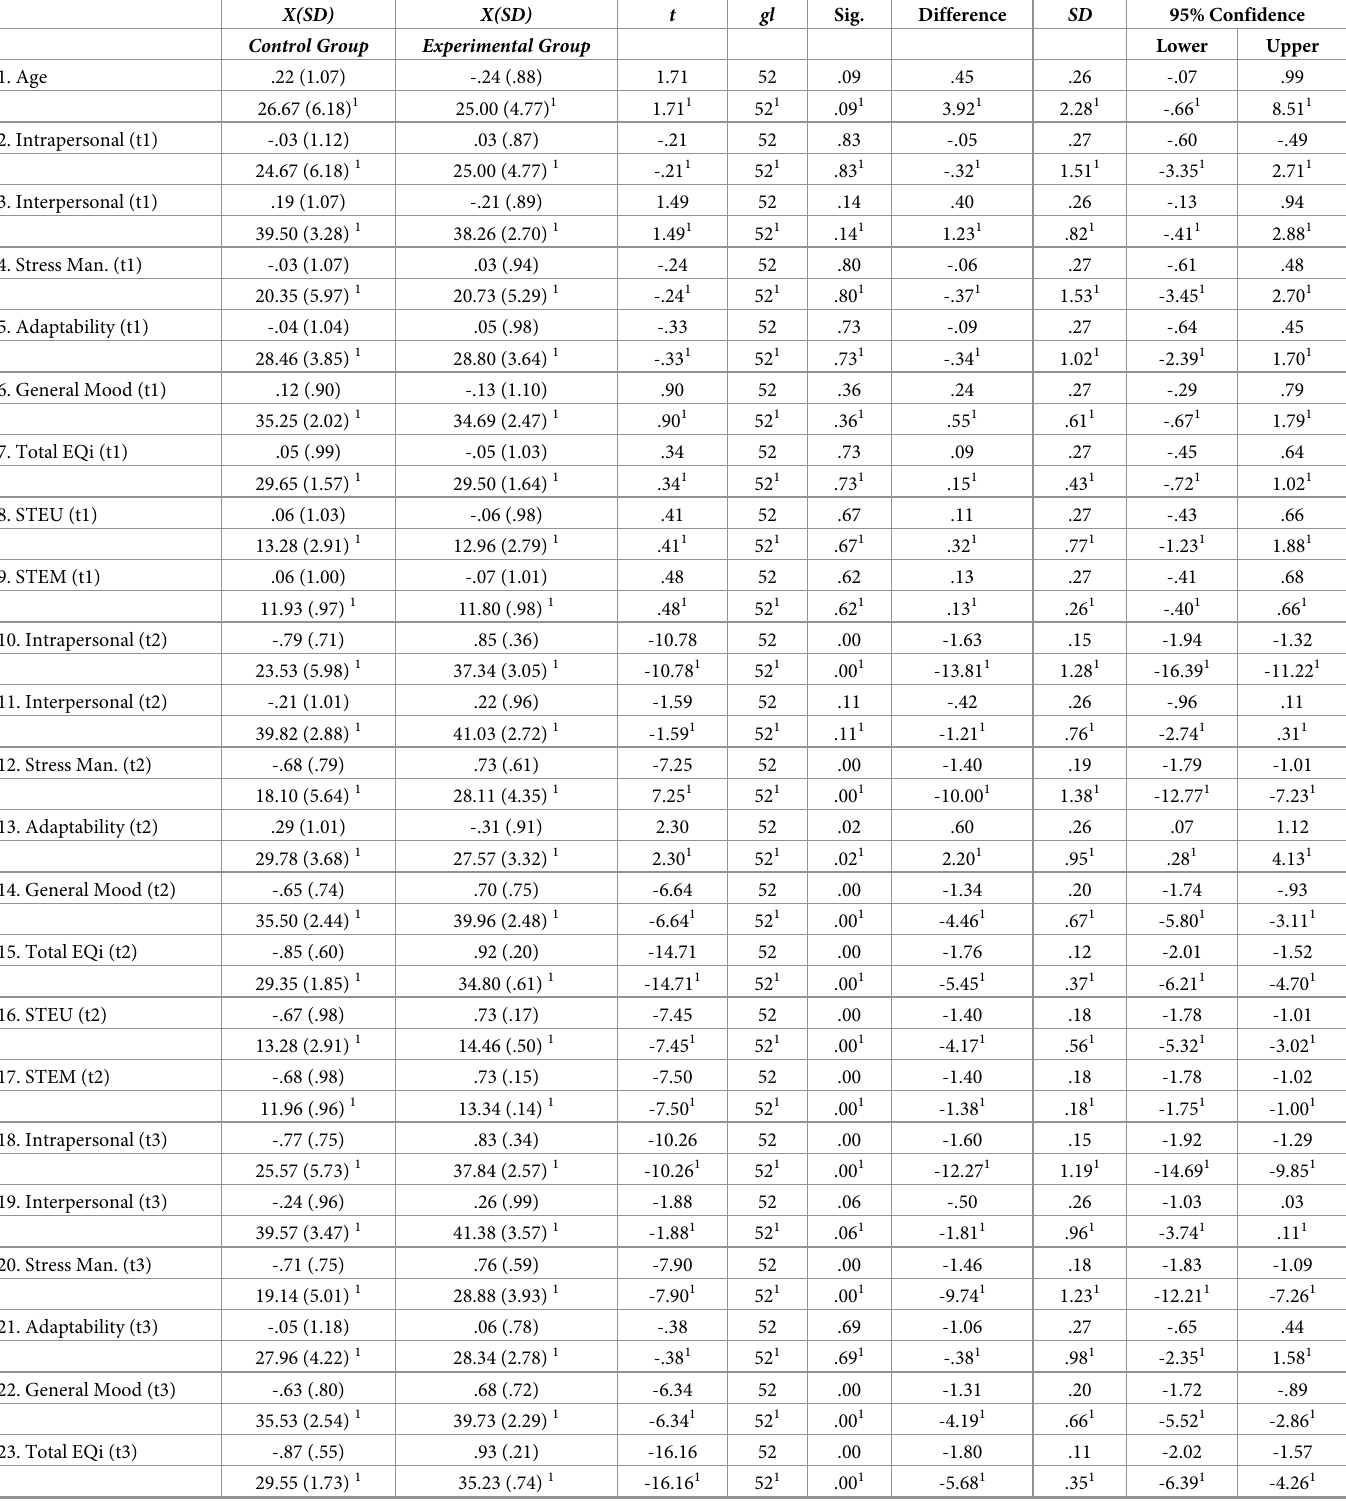
Table 1. Student’s t-test of differences in means (t1, t2,